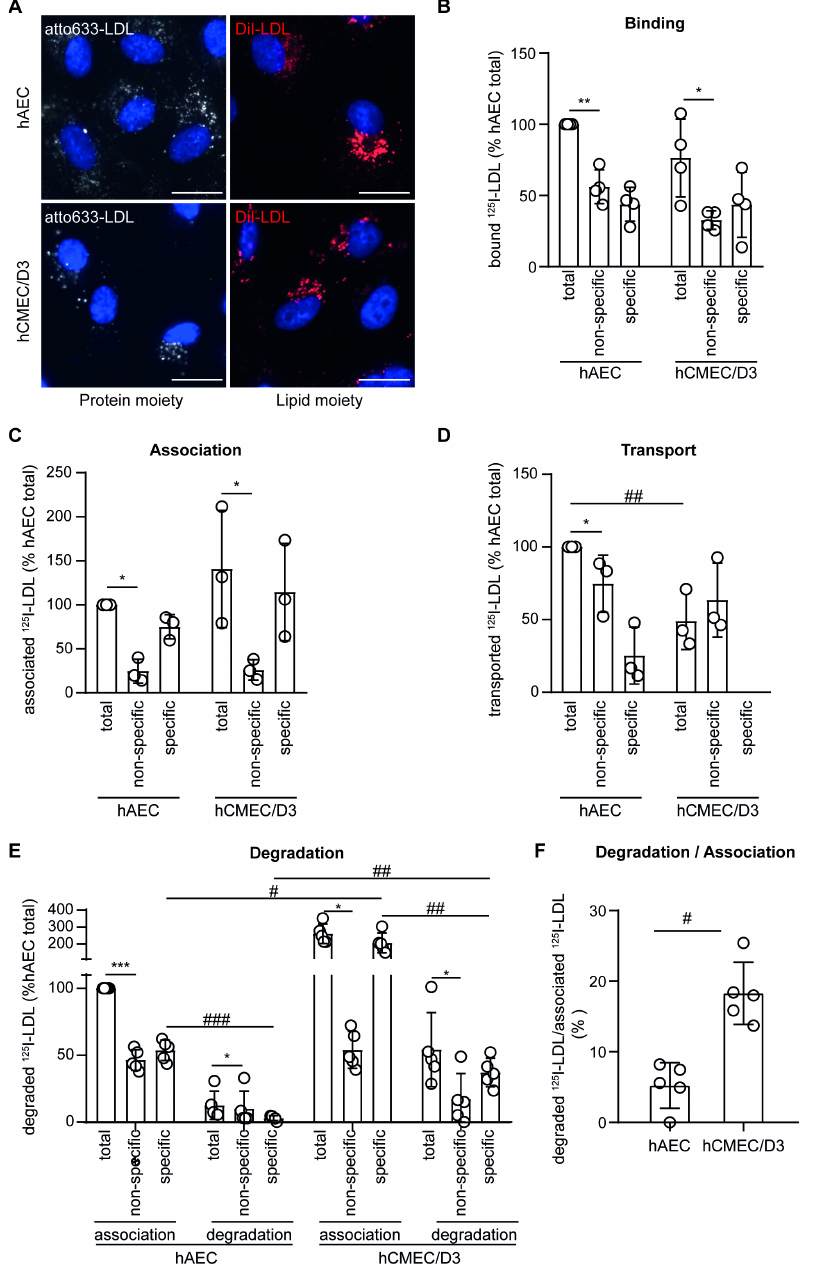
Figure 1. LDL is transcytosed through hAEC but degraded by hCMEC/D3. ( A ) HAEC and hCMEC/D3 were incubated with atto-655 LDL (50 µ g/mL). After 3 h endothelial cells were fixed, counterstained